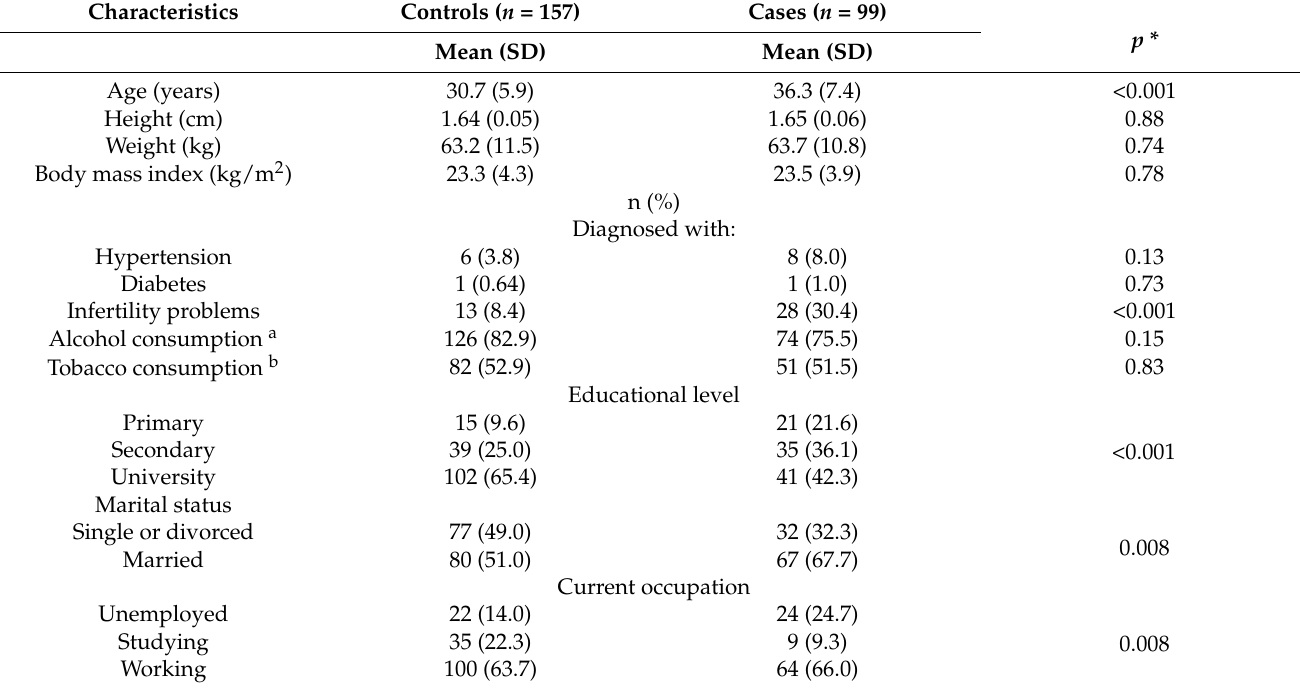
Table 1. Comparison of the general characteristics of cases of endometriosis and controls.